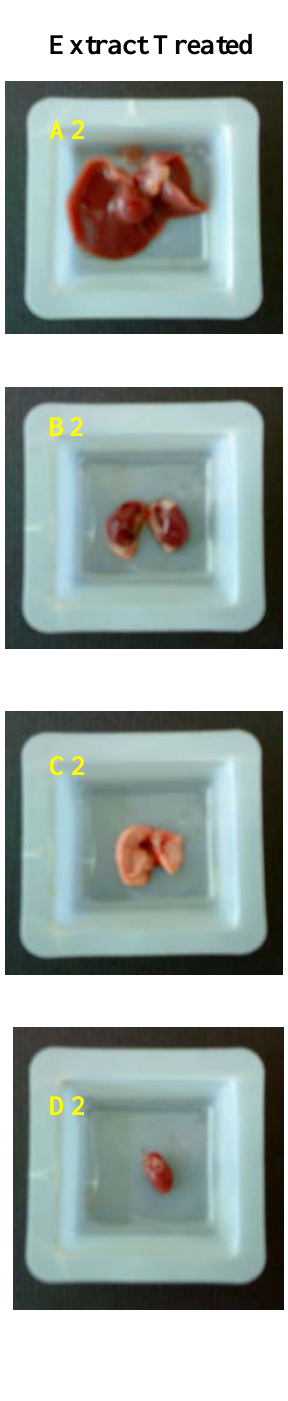
Figure 1. Gross observation of systemic organs: liver (A1 and A2), kidney (B1 and B2), lung (C1 and C2), heart (D1 and D2) and spleen (E1 and E2) from control and extract treated